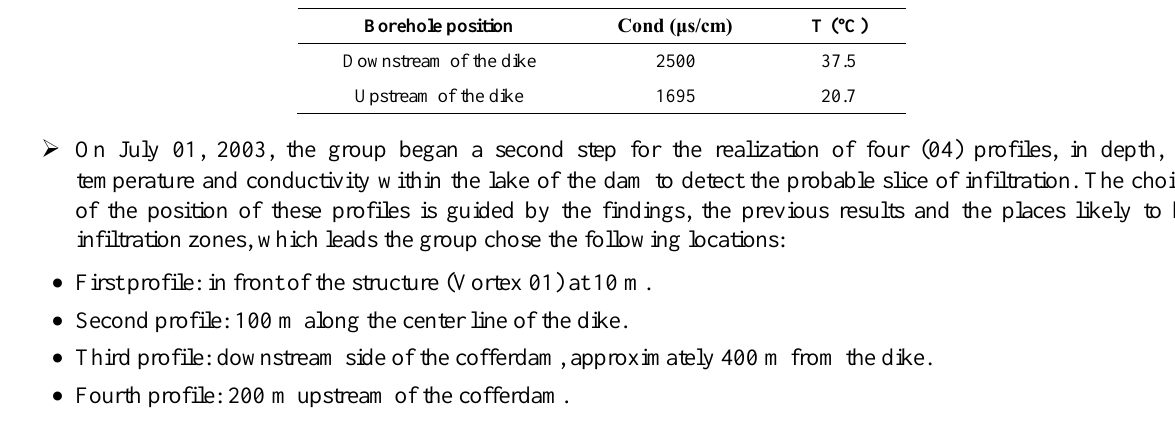
Table 2. Conductivity and temperature results at selected